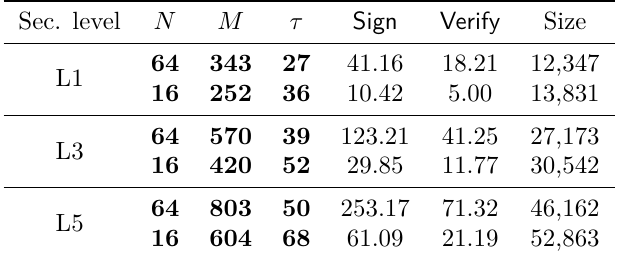
Table 3: Benchmarks for various choices of MPC parameters ( N, M, τ ) grouped by N , the number of parties. Time required for Sign and Verify are given in milliseconds on the reference platform, and the signature size is given in bytes. The current 64-party instances and new 16-party instances are